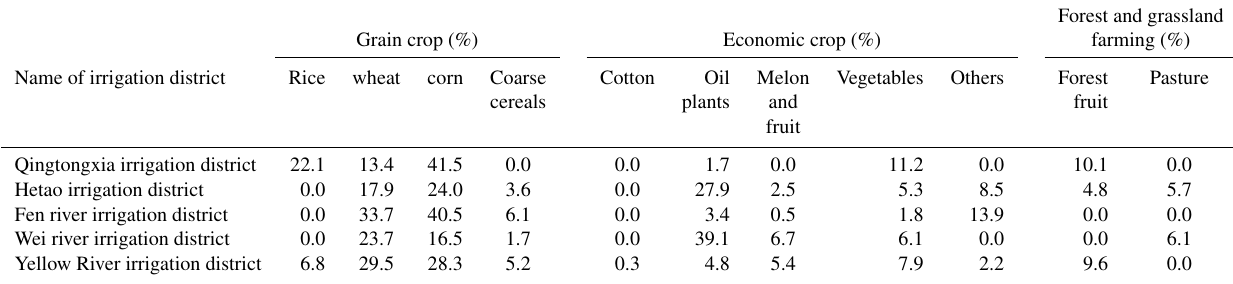
Table 3. Agricultural planting structure of main irrigation districts of Yellow River in 2010. Forest and grassland Grain crop (%) Economic crop (%) farming (%) Name of irrigation district Melon Vegetables Others Forest Pasture cereals plants and fruit fruit